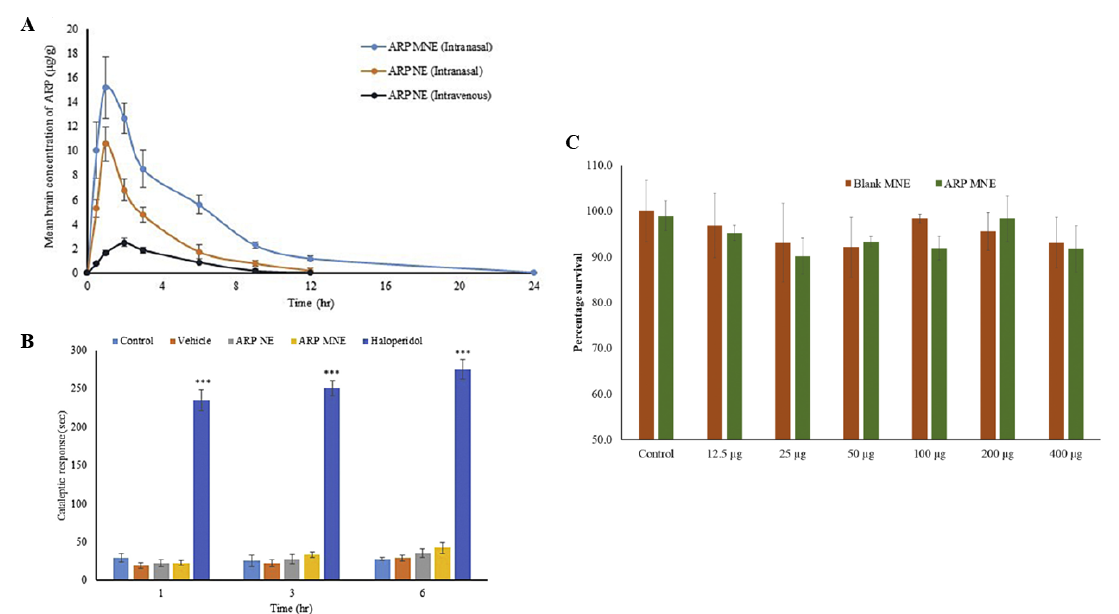
Figure 6. ( A ) Brain drug concentration vs. time profile after intranasal administration of aripiprazole non-mucoadhesive nanoemulsion (ARP NE (Intranasal)) and mucoadhesive nanoemulsion (ARP MNE (Intranasal)), and after intravenous administration of the non-mucoadhesive nanoemulsion (ARP NE (Intravenous)); ( B ) cataleptic response on the 21st day after intranasal administration of the aripiprazole non-mucoadhesive nanoemulsion (ARP NE) and mucoadhesive nanoemulsion (ARP MNE) (compared to vehicle and controls); ( C ) cytotoxicity results after vero cell exposure to the aripiprazole mucoadhesive nanoemulsion (ARP MNE) and blank vehicle (blank MNE); adapted from Kumbhar et al. [37], reproduced with permission from Elsevier [License Number 5393030780780]. *** p < 0.001 vs. control group.